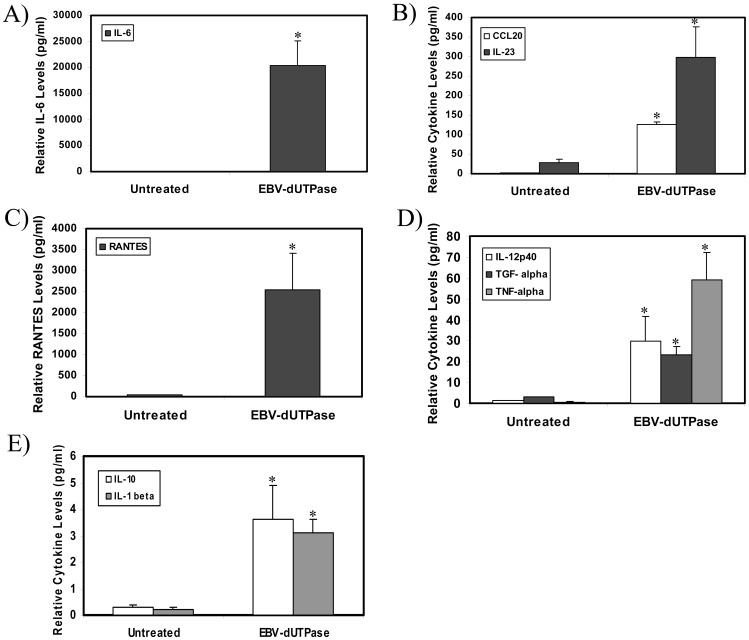
EBV-encoded dUTPase induces the secretion of cytokines and chemokine in human DCs.EBV-encoded dUTPase (10 µg/ml) differentially induce the secretion of TH1, TH17 cytokines/chemokines in hDCs following a 24 h treatment, as determined by proteome array. (A) IL-6; (B) CCL20 and IL-23; (C) RANTES; (D) IL12p40, TGF-α and TNF-α; (E) IL-10 and IL-1β. Cytokine/chemokine concentrations represent the average ± SD (picograms per milliliter) from two independent experiments (n of 4). *p<0.05.